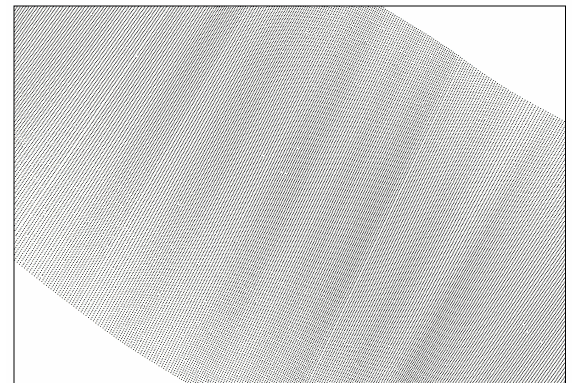
Figure 5. Local scatter plot(X-Y